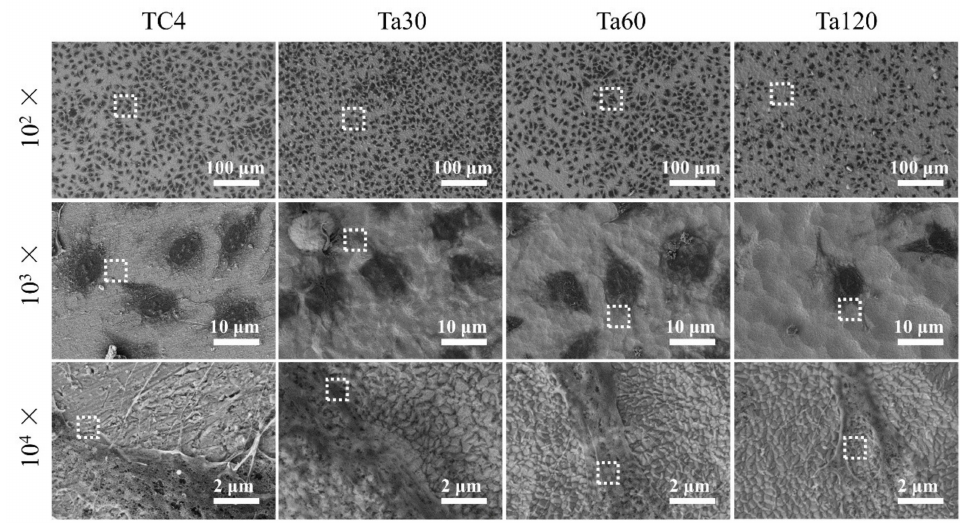
Figure 8. SEM images of osteoblasts after culturing on Ta coatings for 1 day. Mirror polished TC4 was used as control. Figures at higher magnification were taken from the area enclosed by a white square in the figures taken at lower magnification.